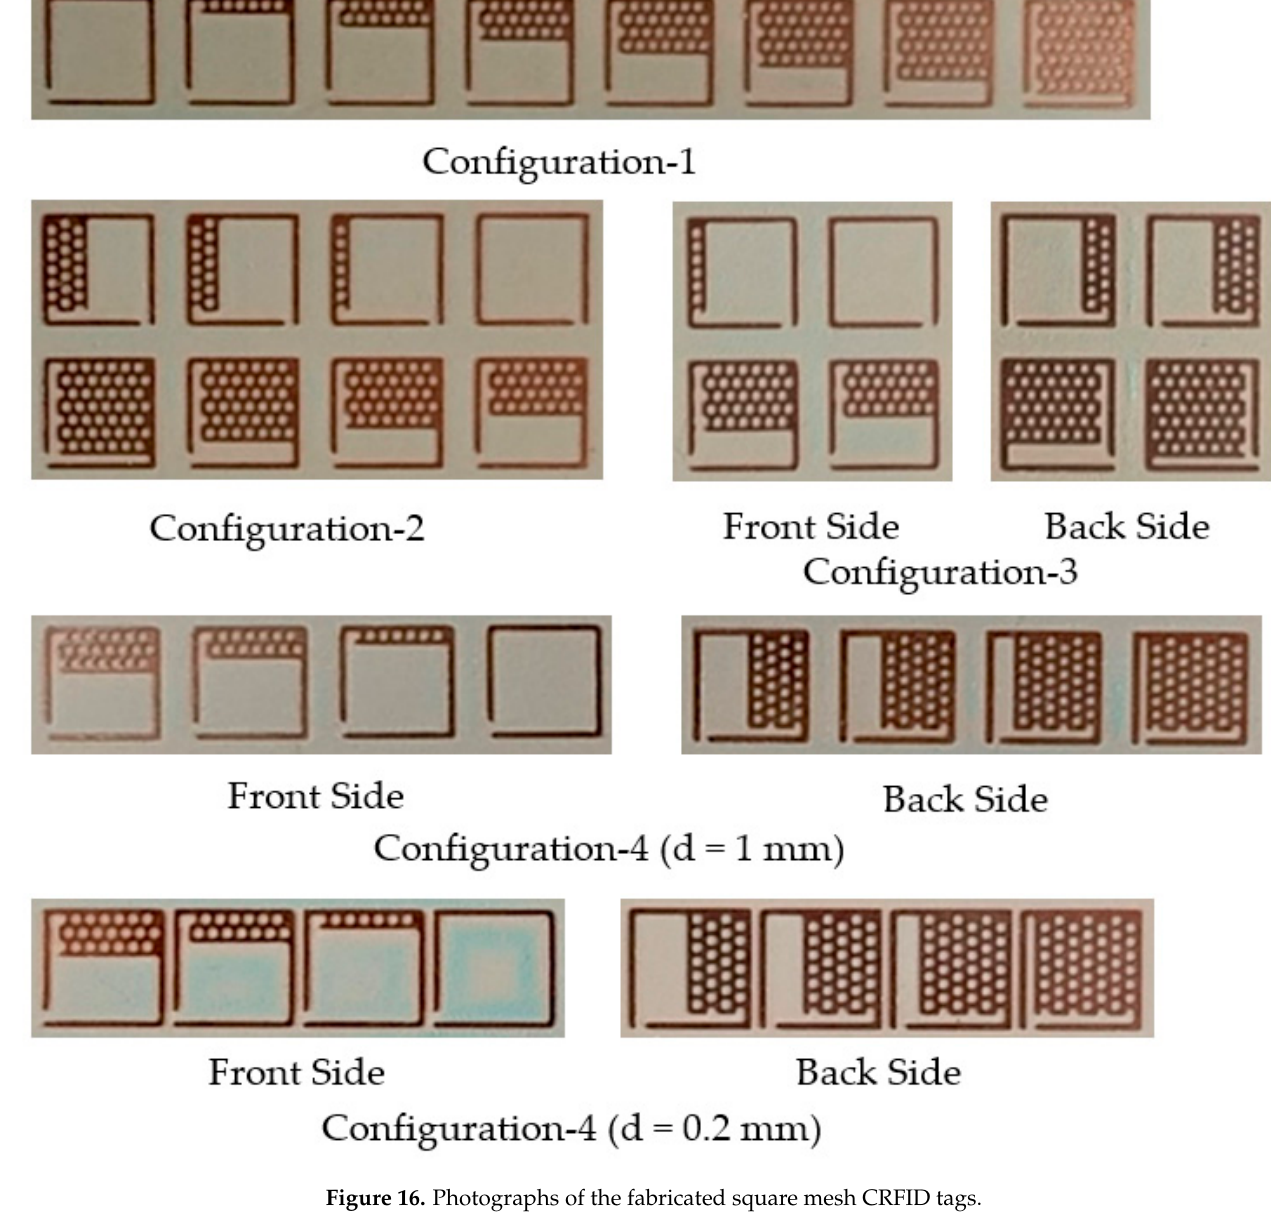
Figure 16. Photographs of the fabricated square mesh CRFID tags.